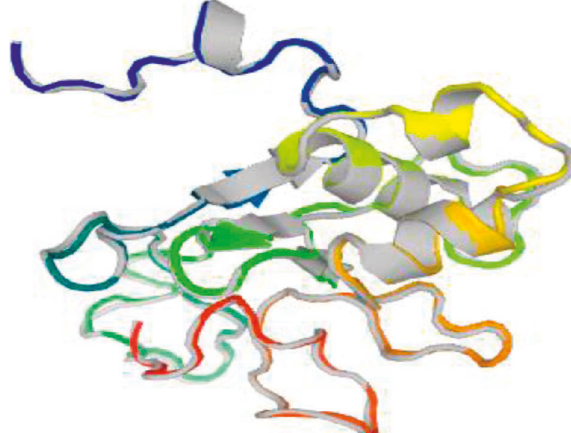
Figure 2: 3D protein structural prediction of the 149-amino acid PfAMA1 protein sequence obtained in the study (using galaxy. seoklab.org).